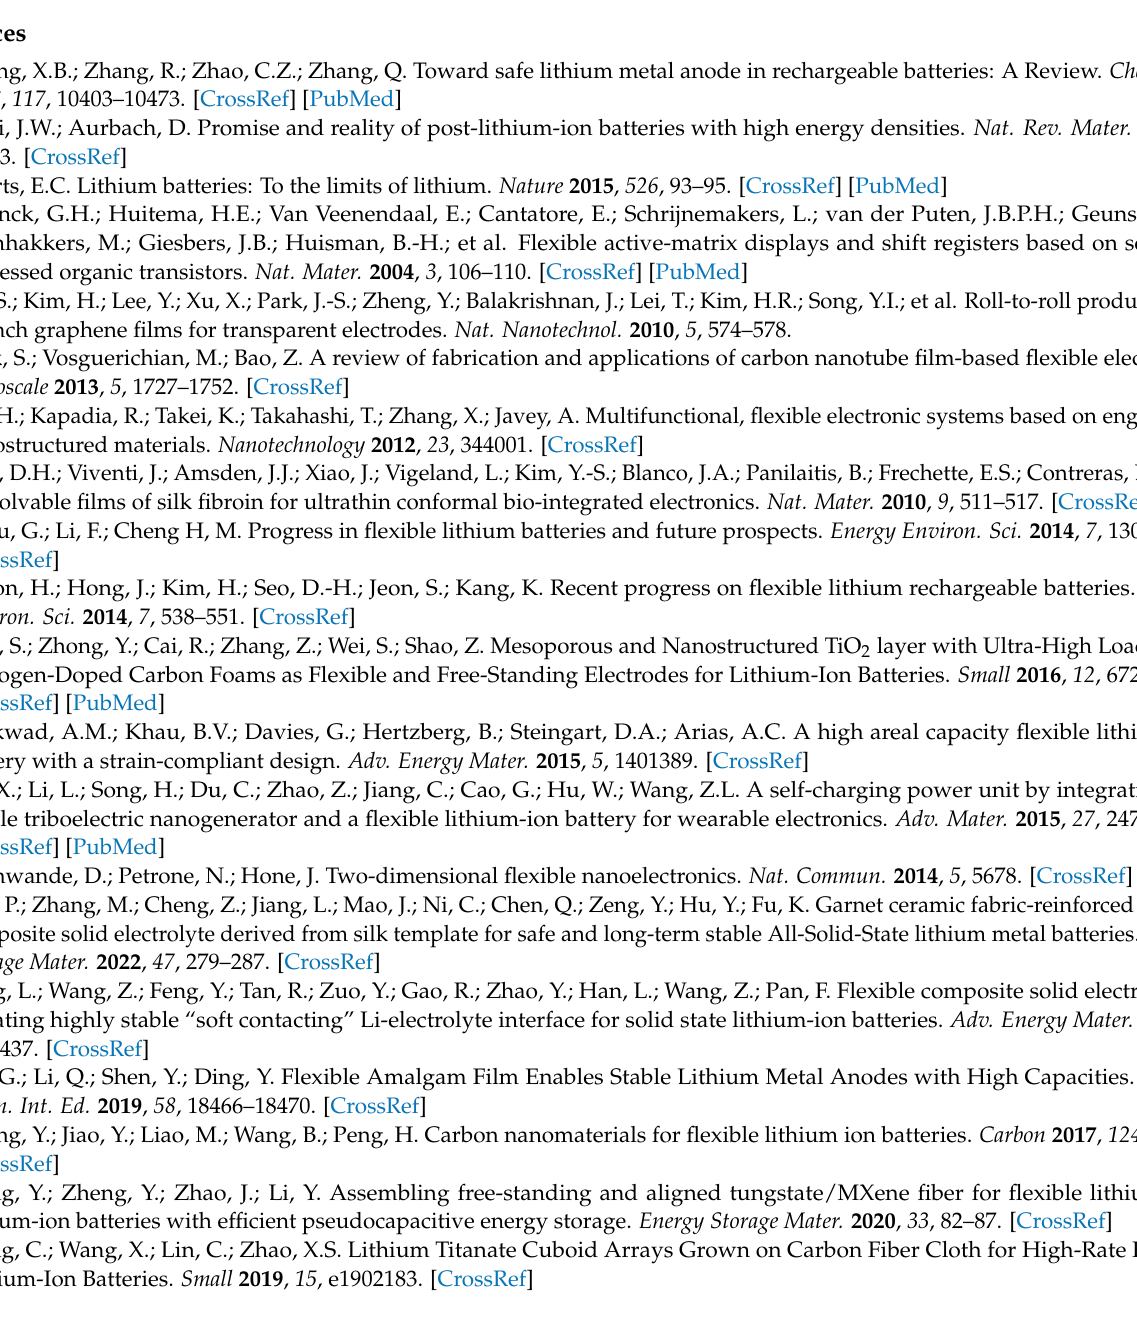
magnification; Figure S4: STEM image and EDS elemental mappings of Nb/Ni@NC nanofiber; Figure S5: Nyquist plots of the flexible Nb/Ni@NC and NC electrodes; Figure S6: Results of particle size analysis of Ni ( a ) and Nb ( b )